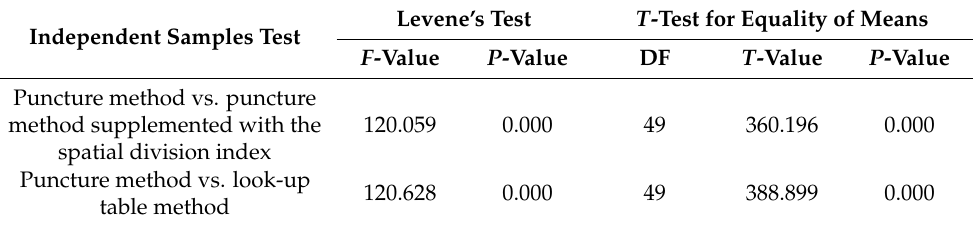
Table 10. Comparisons of grouping the eight-segment layers with different samples using the look-up table method.